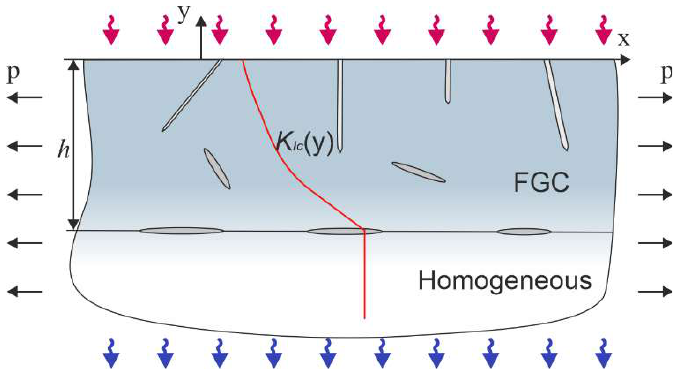
Figure 1. FGC/H structure with a system of cracks under the influence of thermal and mechanical loads. The fracture toughness K Ic (y) changes with the y-coordinate through the FGC thickness. Pre-existing systems of cracks (length 2a k ) in the FGCs were considered. A global coordinate system (x, y) with the x-axis lying on the FGC’s surface was introduced, and the local coordinates (x k , y k ) refer to each crack, with the x k -axis on the crack lines, as shown in Figure 2a. The position of cracks was determined explicitly by their midpoint coordinates (x k0 , y k0 ) (or in the complex form z k0 = x k0 + iy k0 , where i is the imaginary unit) and the inclination angles α k to the x-axis, or β k for edge cracks (β k = –α k ), see Figure 2a. The following assumptions were used for this problem. (1) The uncoupled, quasi- static thermo-elasticity theory was applied, i.e., that the temperature distribution is inde- continuous functions of the thickness coordinate y. (3) The non-homogeneity of the func- stress distributions on the surfaces of cracks [17,24,25]. These assumptions were also used in our previous works (e.g., see [19–23]).